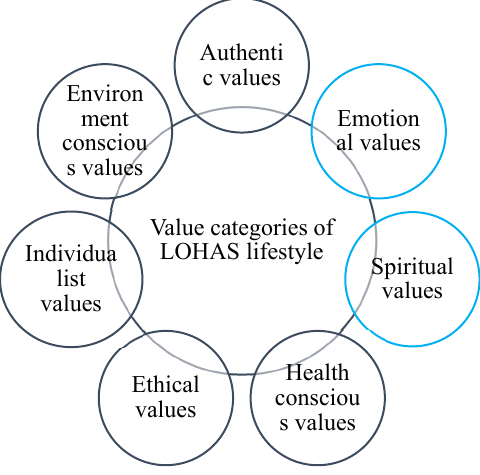
Figure 1. Determining value categories of the LOHAS lifestyle—extended model. Source: Authors’ own compilation based on (Gelfer 2010; Szakály et al. 2015; Choi and Feinberg 2021).